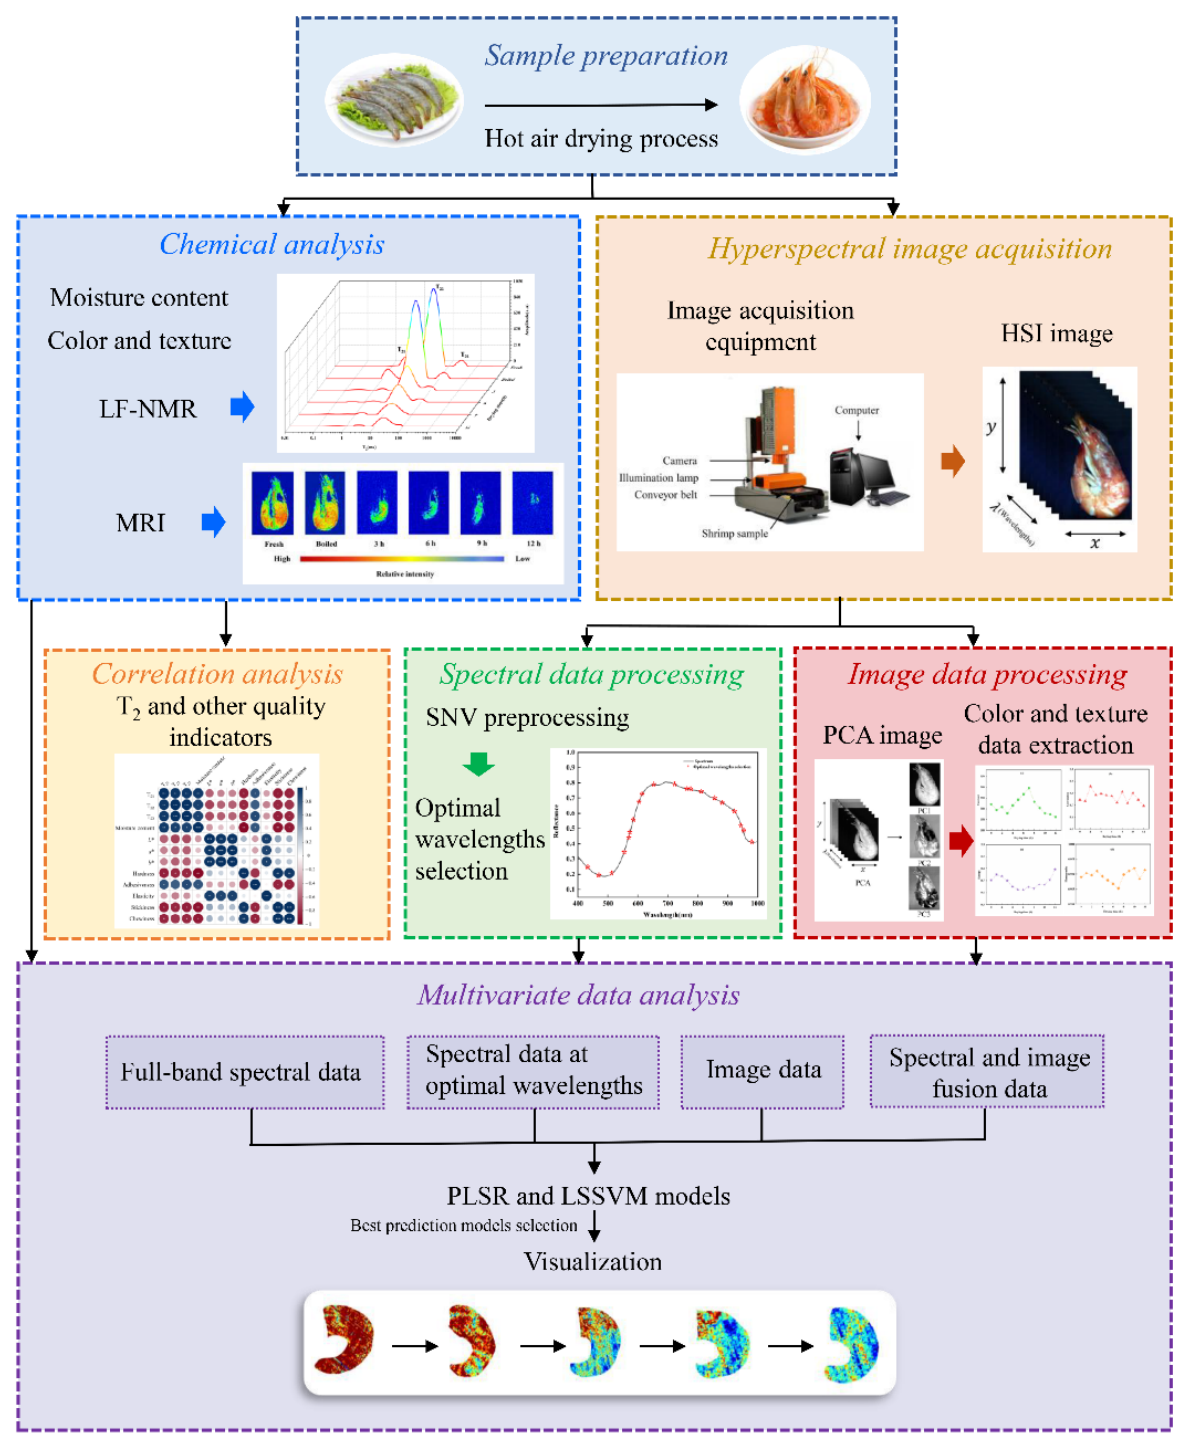
Figure 1. Flowchart of data analyses.